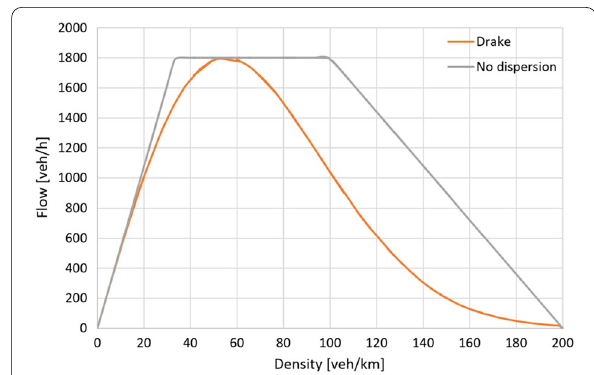
Fig. 2 fundamental diagram: flow–density relationship